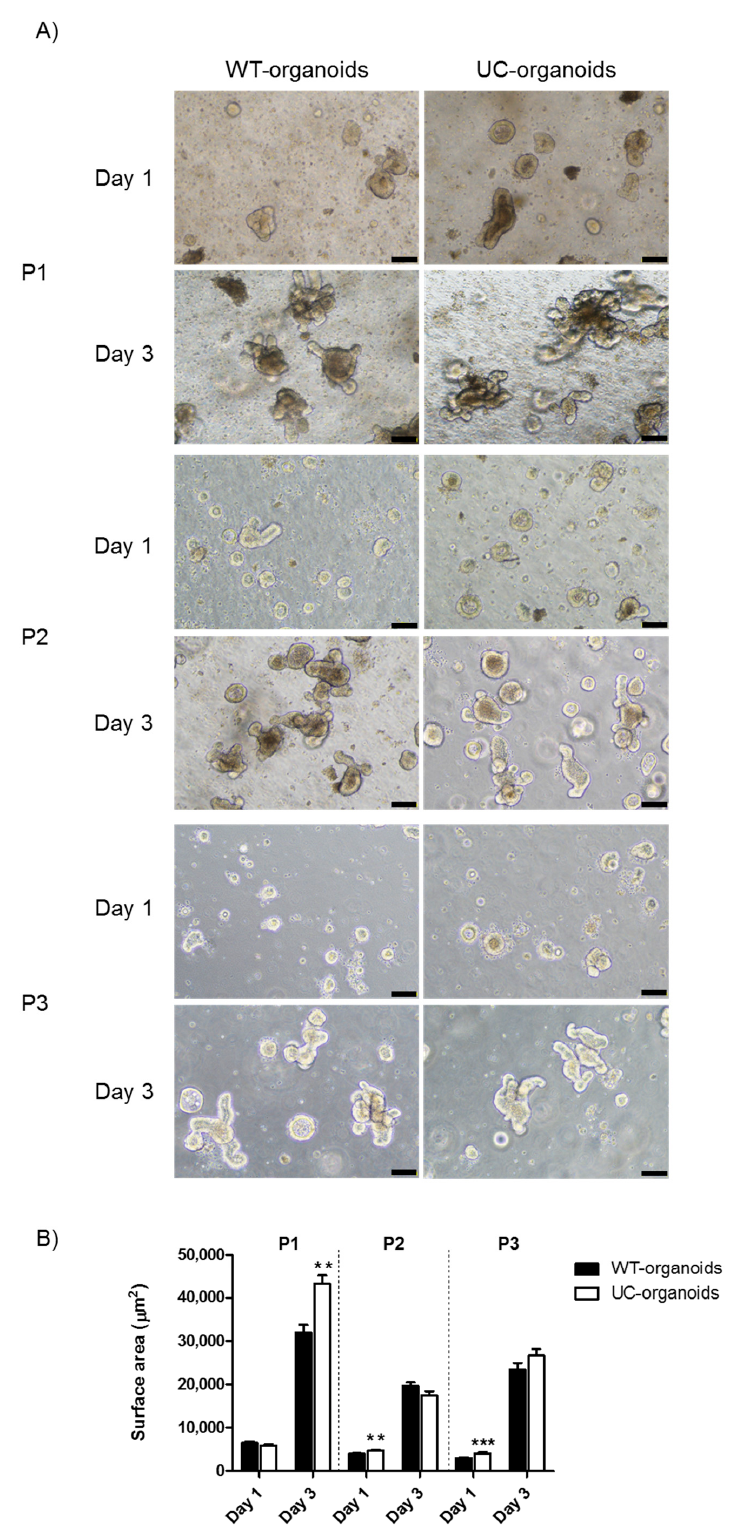
Figure 1. Proliferation of WT- and UC-organoids over time. ( A ) Representative images of WT- and UC-organoids on day one and three, after seeding in Matrigel. Magnification 10 × , scale bars 100 µ m. ( B ) Average surface area of organoids. Histograms represent mean surface area ( µ m 2 ) ± SEM of four independent experiments. Unpaired two-tailed Student’s t-test was used for statistical analysis. *** p < 0.001, ** p <